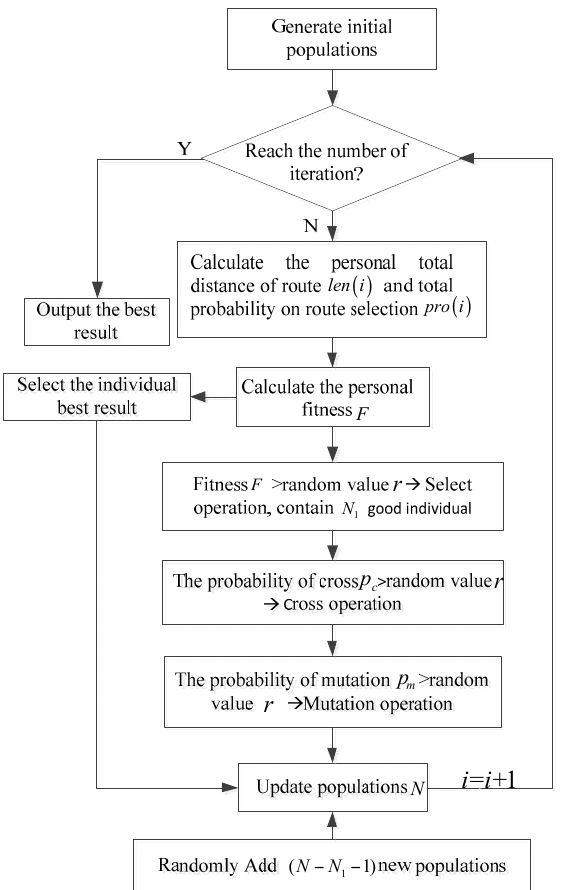
Figure 3. The flowchart of the route planning algorithm for the movement of MSs.